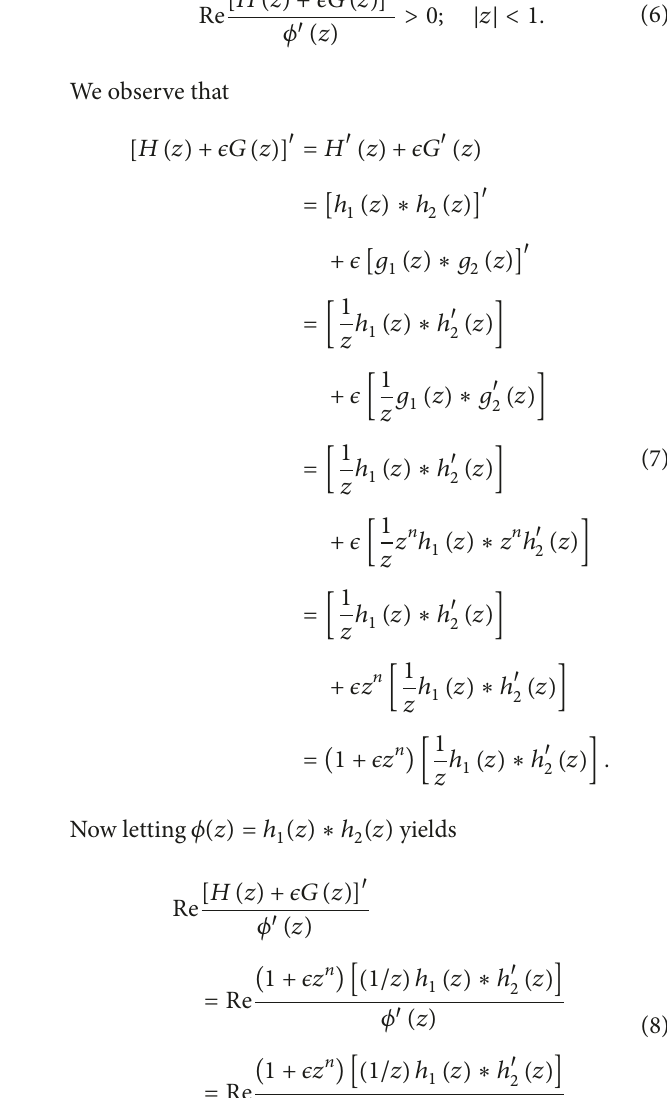
Figure 3: Image of 𝐸 under 𝑓 1 ∗ 𝑓 2